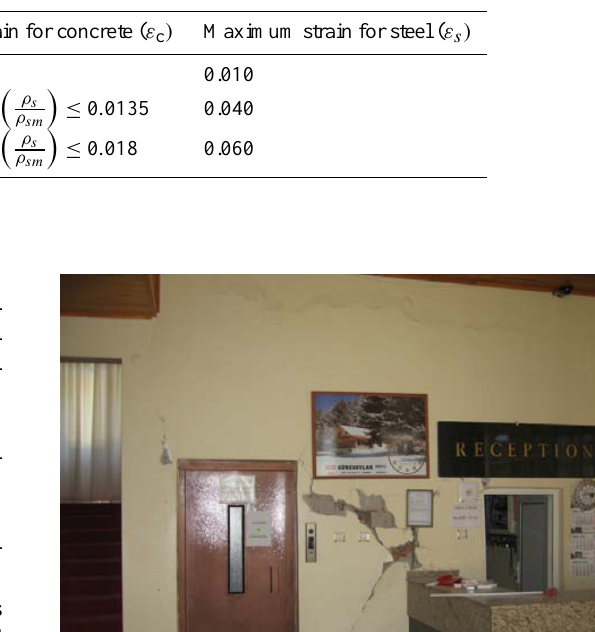
Table 4. Cross-sectional damage